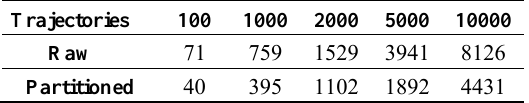
Table 1. Secondary storage usage of trajectories (KB) Trajectories